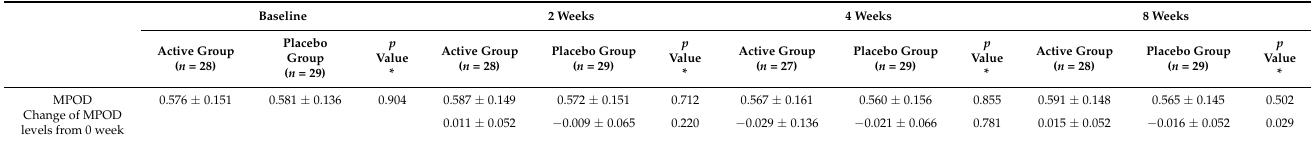
Table 5. The results of the MPOD